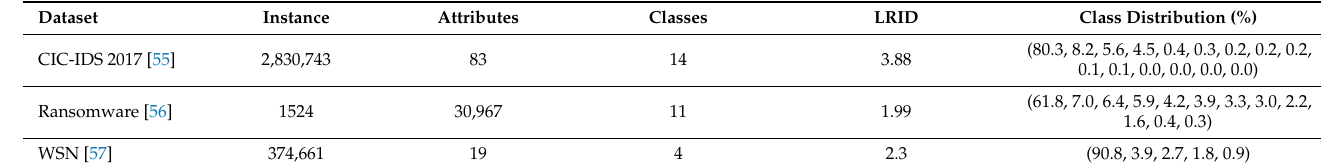
Table 4. Imbalanced datasets